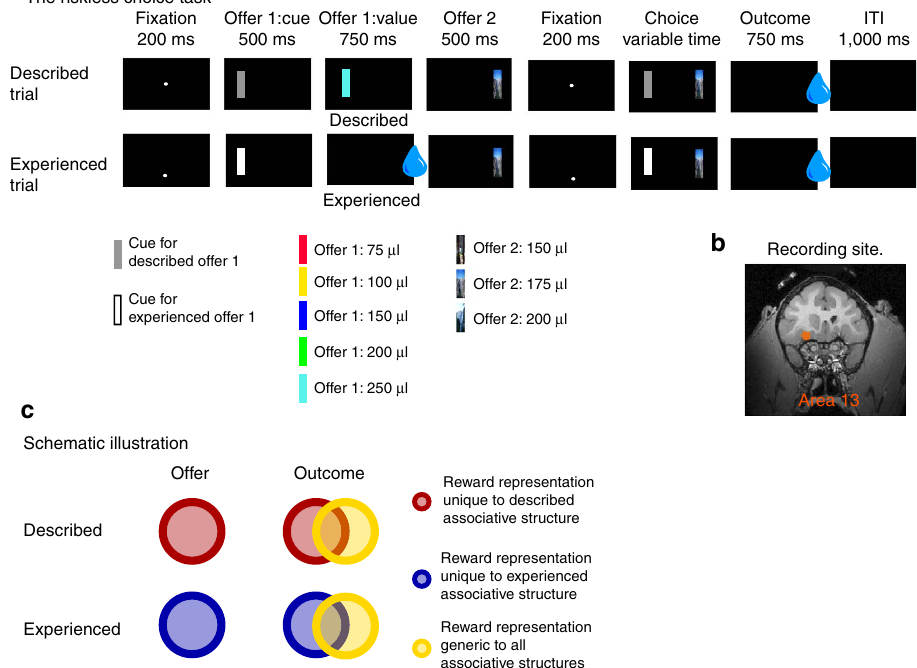
Figure 1 | Summary of methods and hypothesis. ( a ) The riskless choice task. Following fixation, the offer 1 cue indicated a described or experienced offer 1. The size of the offer was indicated by coloured rectangle (described trials) or a water aliquot (experienced trials). Presentation of offer 2 followed, and, after a fixation, subject chose by shifting gaze to one of the offer positions. ( b ) Recording site (subject H shown). Area 13 of OFC is highlighted in orange. ( c ) Schematic illustration of our hypothesis. Outcome responses specific to different associative structures were reactivated during prospective evaluation but general reward response insensitive to preceding associative structures was only present during reward delivery after the